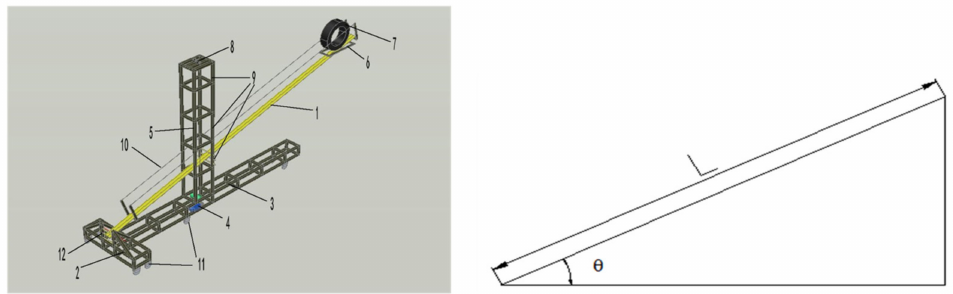
Figure 2. 3D model of indoor tire-rolling-down test system and calculation diagram of tire falling speed.